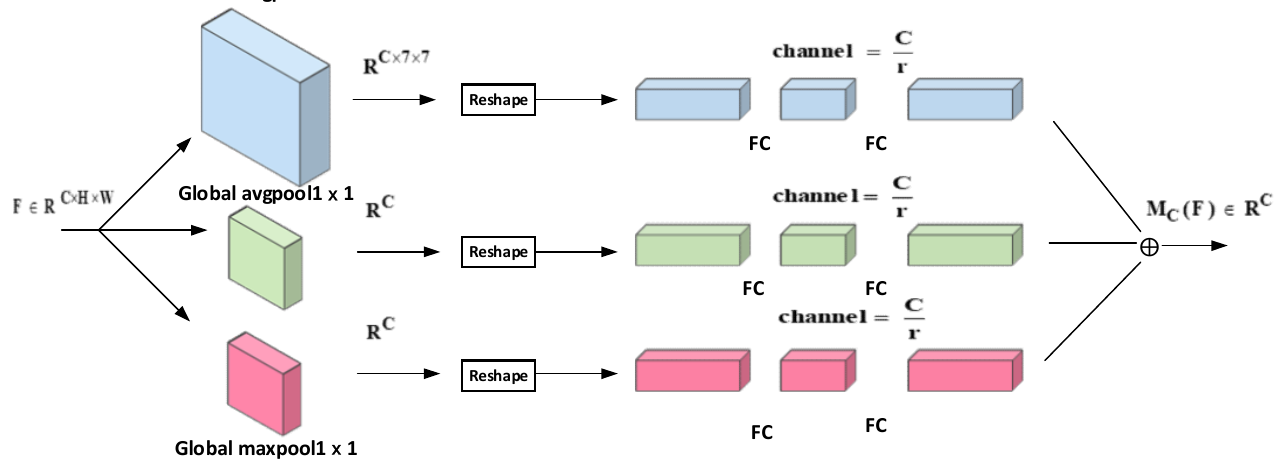
Figure 5. Channel attention of OCAM attention module.